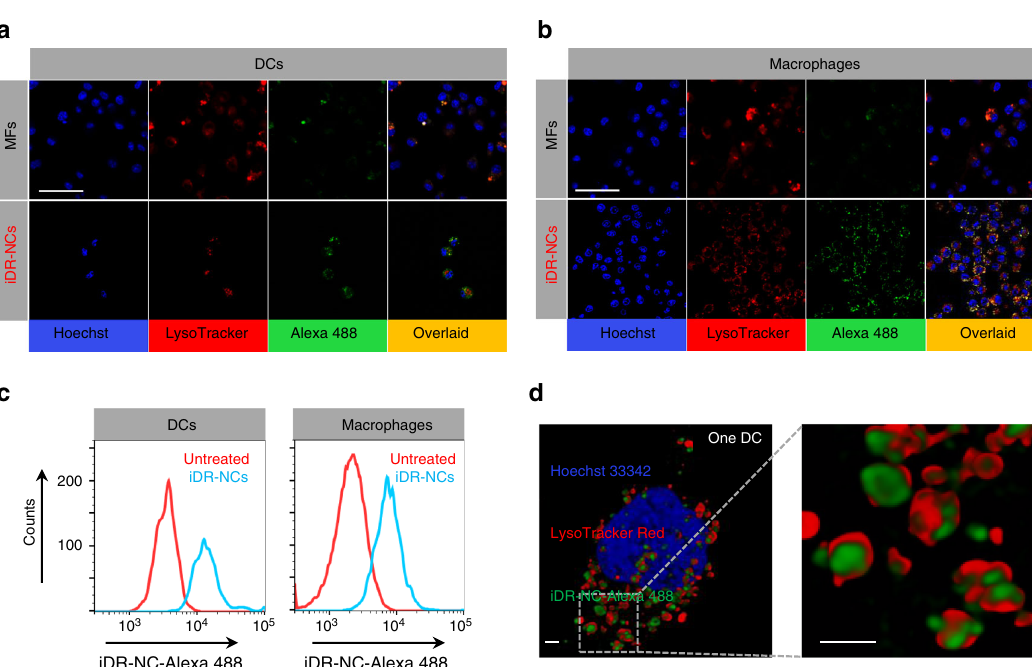
Fig. 3 Ef fi cient intracellular delivery of iDR-NCs into APCs. a , b Confocal microscopy images showing that, compared with the unshrunk MFs, Alexa 488- labeled iDR-NCs were more ef fi ciently internalized into DC2.4 cells a and RAW264.7 macrophages b . Scale bar: 50 µ m. Hoechst: Hoechst 33342. LysoTracker: LysoTracker Red DND-99. Ef fi ciently internalized iDR-NCs were co-localized with endolysosome after 3-h incubation. c Flow cytometry graphs showing ef fi cient internalization of Alexa 488-labeled iDR-NCs by DC2.4 cells and RAW264.7 macrophages after 3 h. Red: untreated cells; blue: cells treated with iDR-NCs. d 3D-deconvolved confocal microscopy images showing one DC2.4 cell that internalized iDR-NCs into its endolysosome and cytosol after 3-h incubation. Scale bar: 1 µ m. (iDR-NC concentration: 500 nM CpG 1.5 mV for iDR-NCs due to the positive charge of PPT- g -(PEG) 6